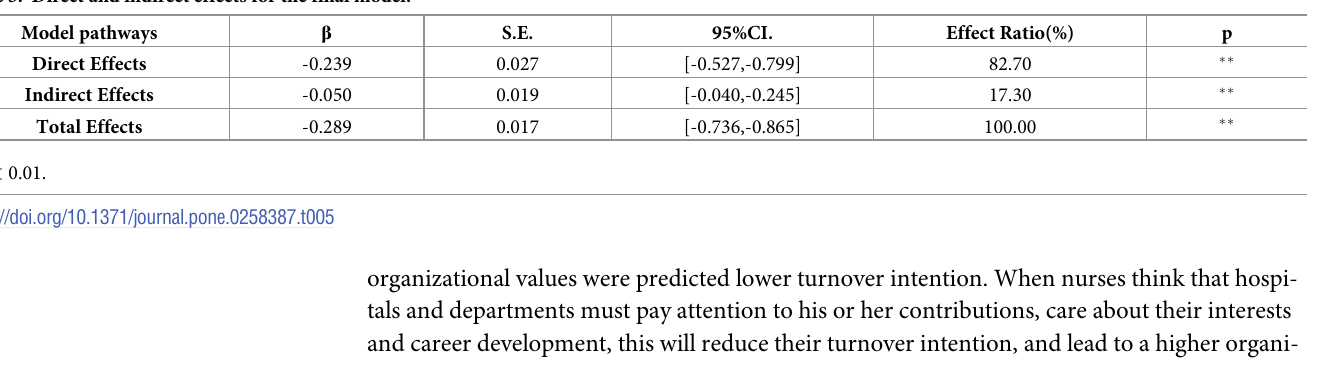
Table 5. Direct and indirect effects for the final